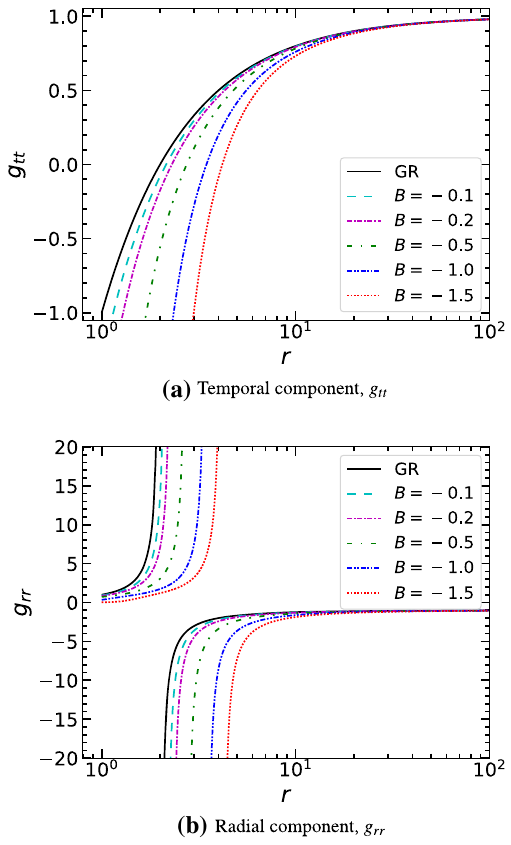
Fig. 1 The variation of temporal and radial metric elements as func- tions of distance r . All the quantities are expressed in dimensionless units, which is considered with c = G = M =